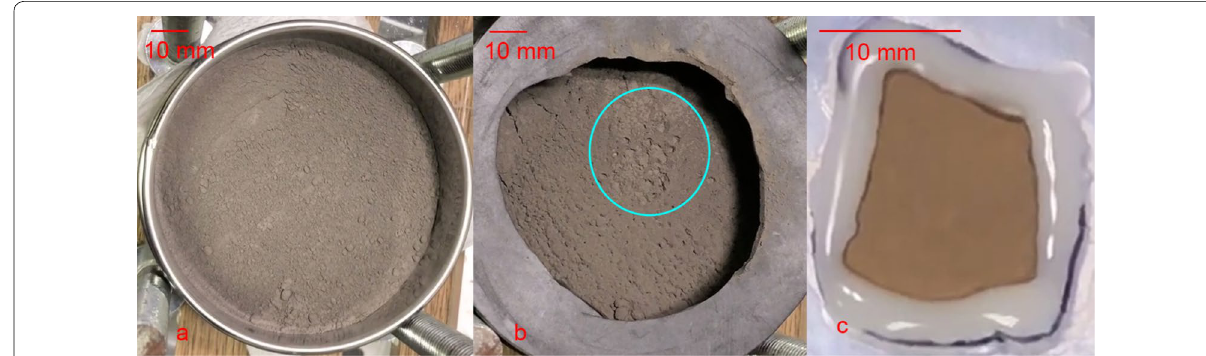
Fig. 11 Photographs of ( a , b ) powder-like ash and c a sintered ash plate. a Before and b after the permeability measurement. The diameter of the sieve is 75 mm, and the thickness of the ash layer is 5 mm. b The blue circle indicates the pipe-like structure. A rubber ring used for sealing is placed on the sieve rim. c The brownish ash plate is embedded in a plastic